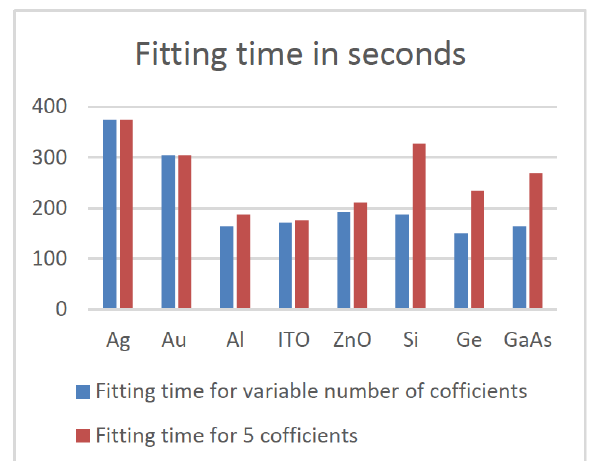
Figure 16. The fitting time required for variable and fixed LD coeffi-